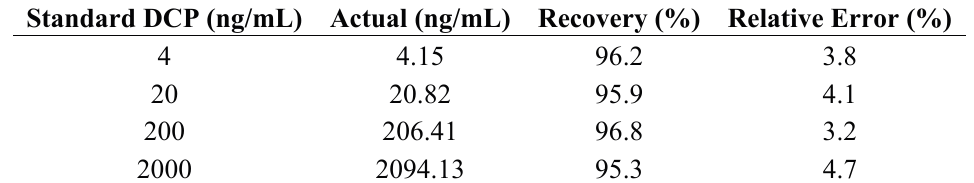
Table 2. Measurements of DCP with interferences of Na + , K + , Ca 2+ , Cl − , glucose, urea, and uric acid at high concentrations (1 μ M for all interferences, and 5 mM for glucose) in BSA. Linear calibration curve (Z" DCP − Z" PBS vs. Log DCP concentration ) in Figure 7 was used, with the linear regression equation of ∆ Z = − 51.38 × Log DCP concentration − 15.10. All measurements were conducted at the optimum measuring frequency of 23.870